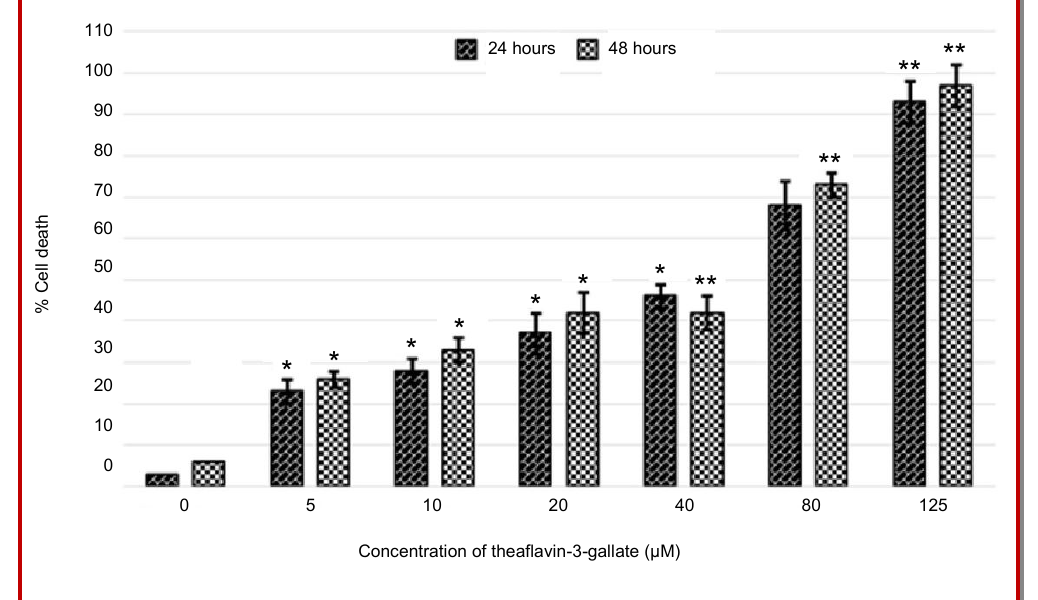
Figure 1: Cytotoxic effect of theaflavin-3-gallate in human non-small cell lung cancer cells (A-549). Data are shown as the mean ± SD of three independent experiments. *p<0.05, **p<0.01 vs 0 µM (control)